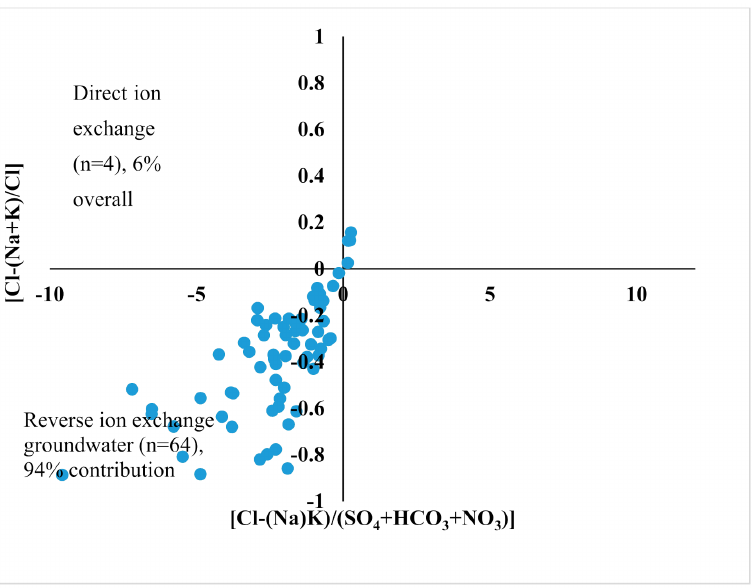
Figure 7. CAI-1 against CAI-2 shows the ion exchange processes in the groundwater samples of Khaniwal district,